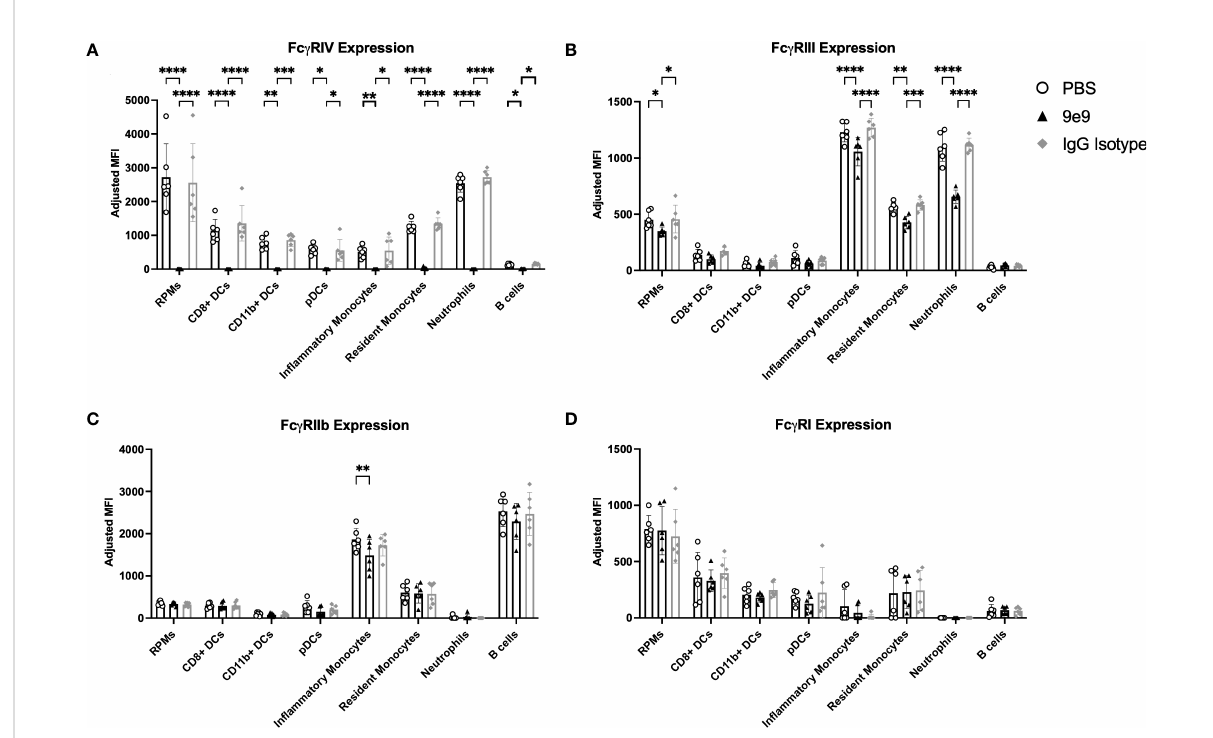
FIGURE 1 Anti-Fc g RIV (clone 9e9) inhibits Fc g RIV. B6 recipient mice received an infusion of 200 m g of anti-Fc g RIV clone 9e9, IgG isotype control, or PBS. Spleens were collected 30 minutes later and processed into single cell suspensions. Splenocytes were stained with antibodies to delineate cell subsets and expression of (A) Fc g RIV, (B) Fc g RIII, (C) Fc g RIIb, or (D) Fc g RI. The mean fl uorescence intensity (MFI) for each individual Fc g R was calculated; a fl uorescence minus one (FMO) was used as a negative control. To determine the adjusted MFI, the MFI of the FMO was subtracted from the MFI of the stain containing the antibody for the Fc g R. The following phenotypes were used to delineate cell subsets: red pulp macrophages (RPMs): CD11c − /lo CD11b − /lo F4/80 + ; CD8 + DCs: CD11c hi CD11b − CD8 + ; CD11b + DCs: CD11c hi CD11b + CD8 − ; plasmacytoid DCs